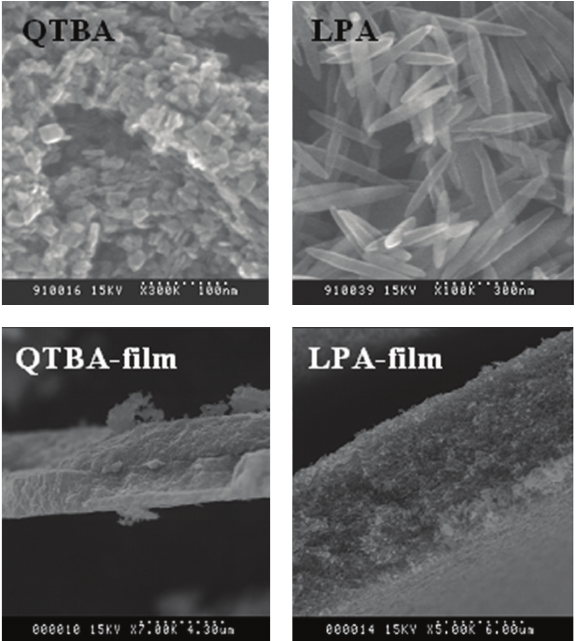
Figure 3: FE-SEM images of anatase TiO 2 nanocrystals QTBA and LPA samples and the films prepared by QTBA and LPA